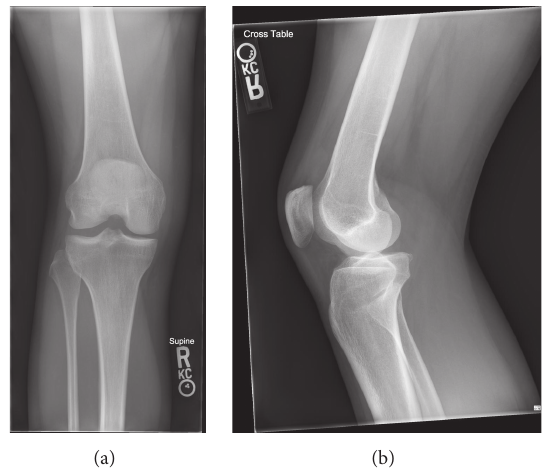
Figure 1: AP (a) and lateral (b) view radiographs of right knee for the evaluation of acute injury. Lateral view demonstrates moderate joint effusion, deepening of the terminal sulcus, and irregularity of the posterior aspect of the lateral tibial plateau.